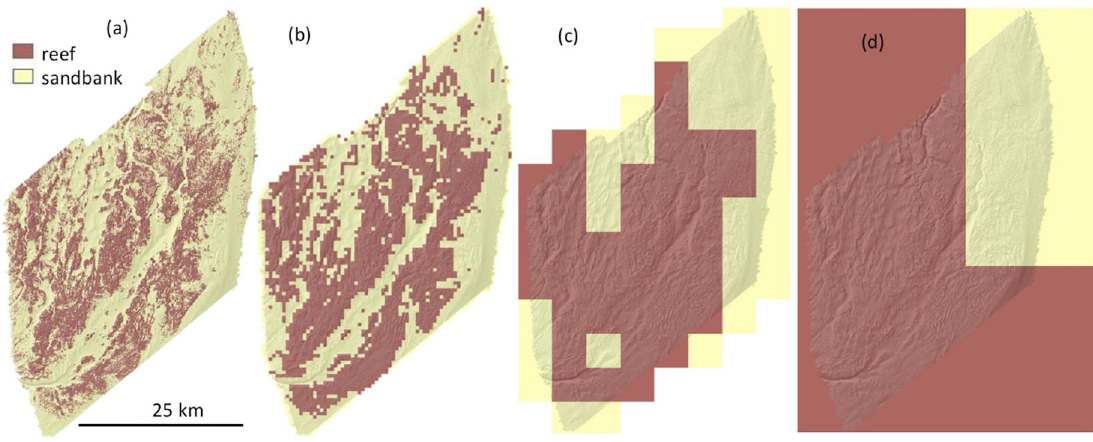
Figure 14. Comparison of Natura 2000 maps created using different scales from 5 m to 25 km analysis window. The definition for “reef” is > 50% hard bottom (the mean hard bottom cover on the bank was 19.3%) or > 10% epibenthic bivalves (the mean Mytilus cover on the bank was 10.7%). The choice of scale changes the cover of each class. ( a ) 5-m resolution (reef 44% coverage), ( b ) 500-m resolution (reef 51% coverage), ( c ) 5 km resolution (reef 55% coverage), ( d ) 25 km resolution (reef 67% coverage). At the scale of the whole bank it would be 100% cover of reef.